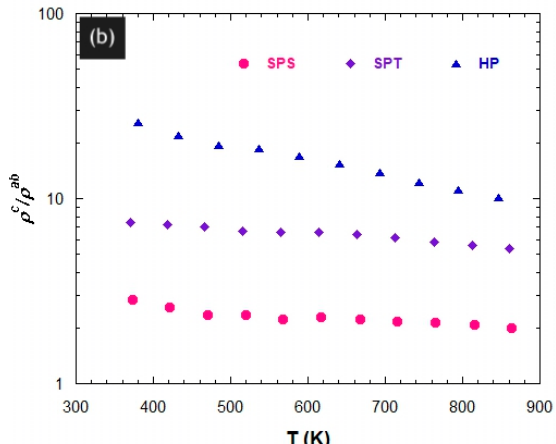
Figure 5. ( a ) Temperature dependence of the electrical resistivity measured on ~2 × 2 × 8–10 mm 3 bars cut from the fabricated SPS, SPT, and HP stacks along their two principal directions: parallel ( ρ c ) and perpendicular ( ρ ab ) to the applied pressing axis. The ρ NS (T) recorded for the NS sample is also given for easy comparison. ( b ) Temperature dependence of the anisotropy in electrical resistivity of the SPS, SPT, and HP samples.